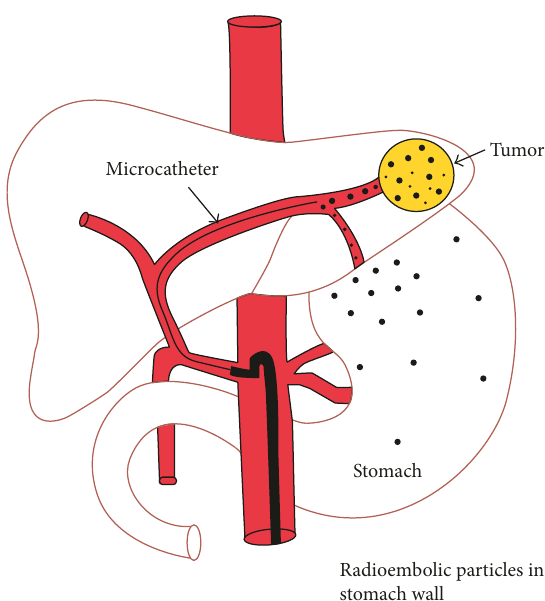
Figure 3: Drawing of aberrant microsphere deposition in the stomach (reproduced with permission of the publisher, Frontiers in Oncology